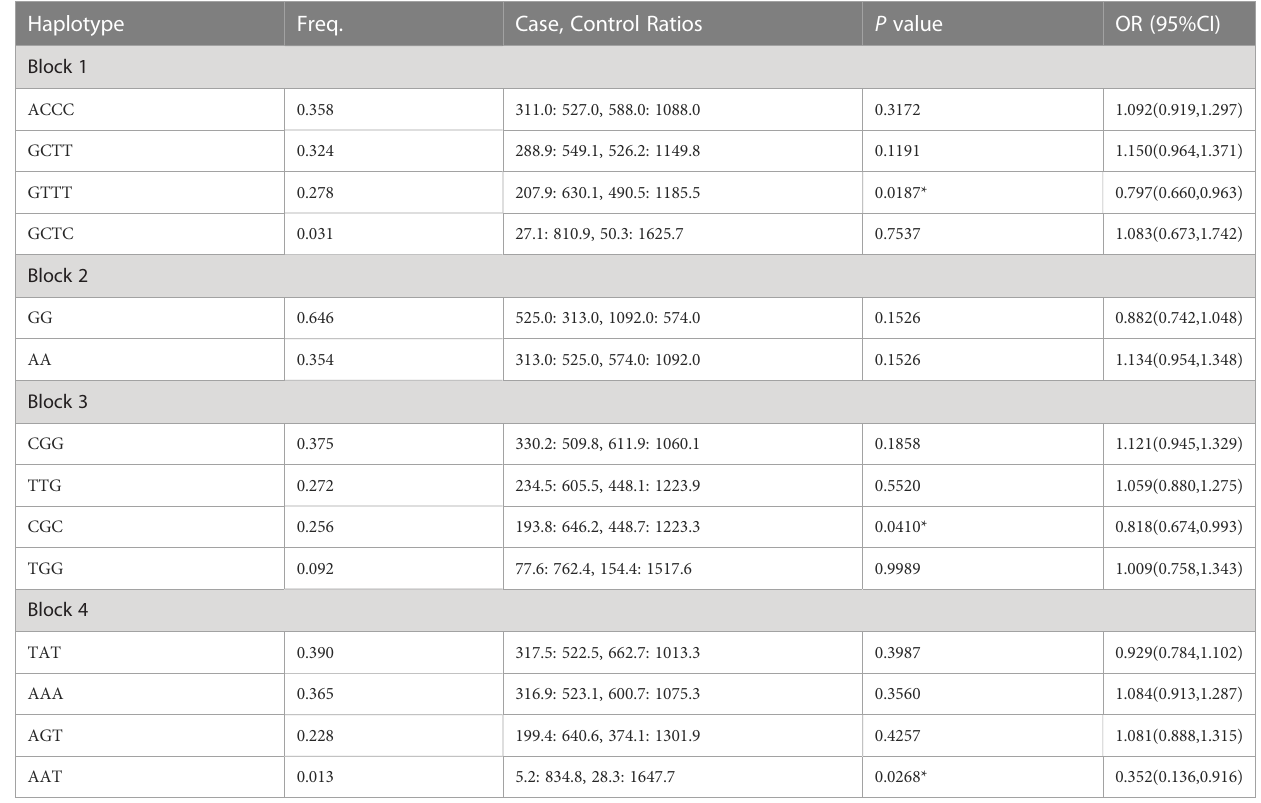
TABLE 2 Haplotype analysis for 13 SNPs in MSH3 gene between HC and HCC groups by Haploview 4.2.